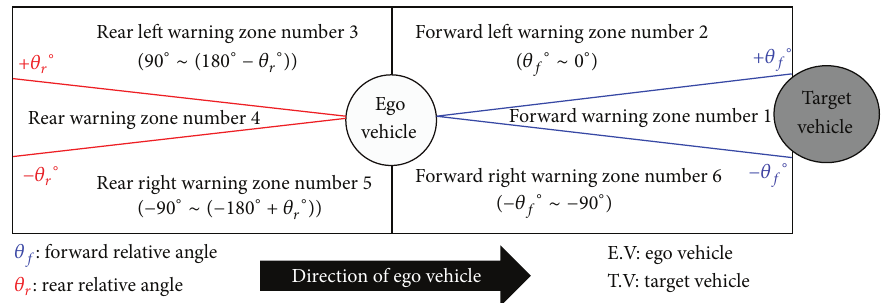
Figure 7: Warning zone corresponding to relative